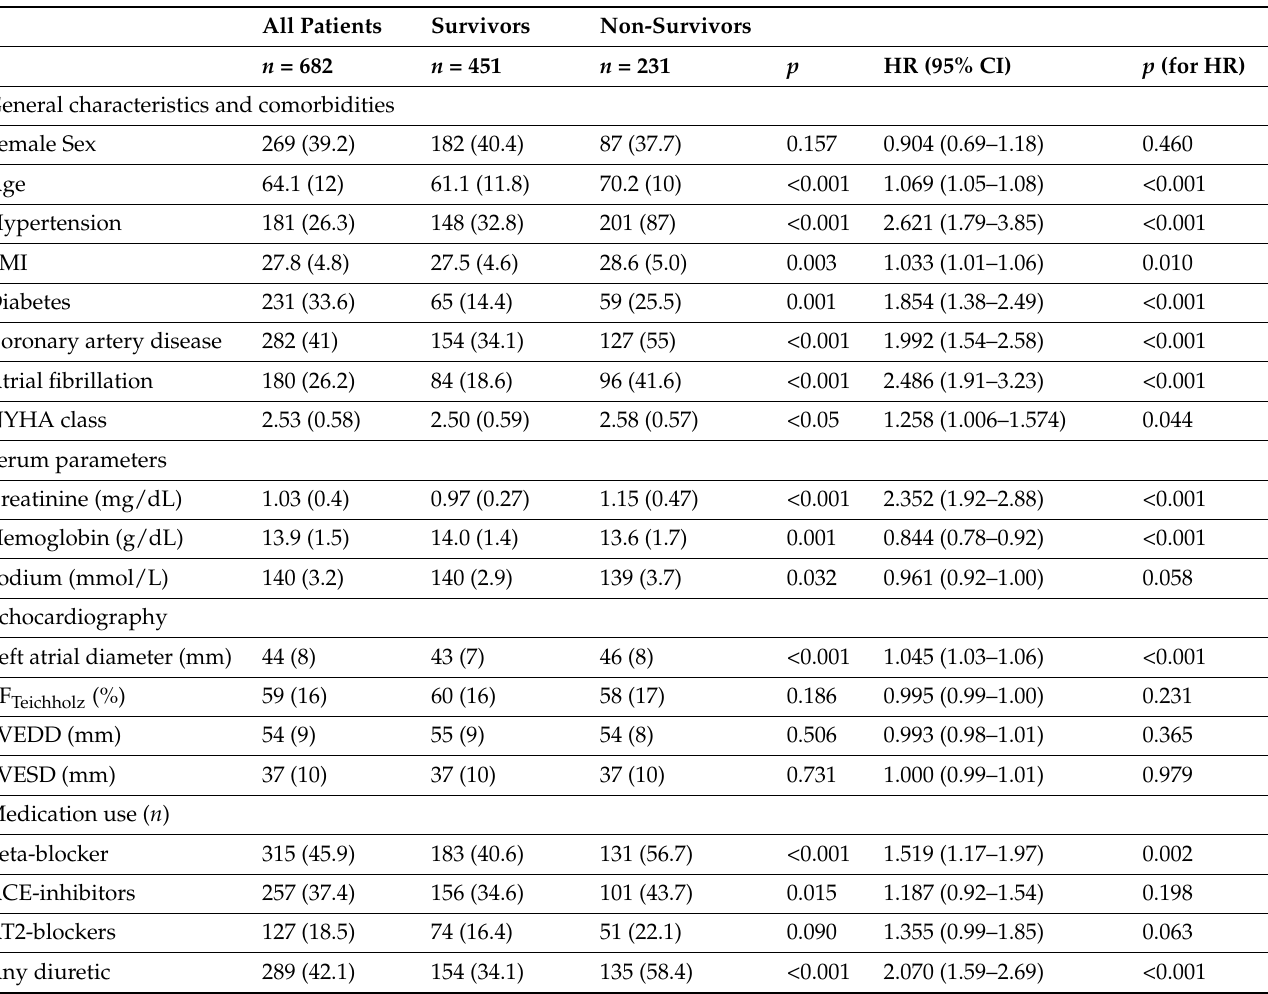
Table 1. Clinical and echocardiographic characteristics with univariable hazard ratios (HRs) for all-cause